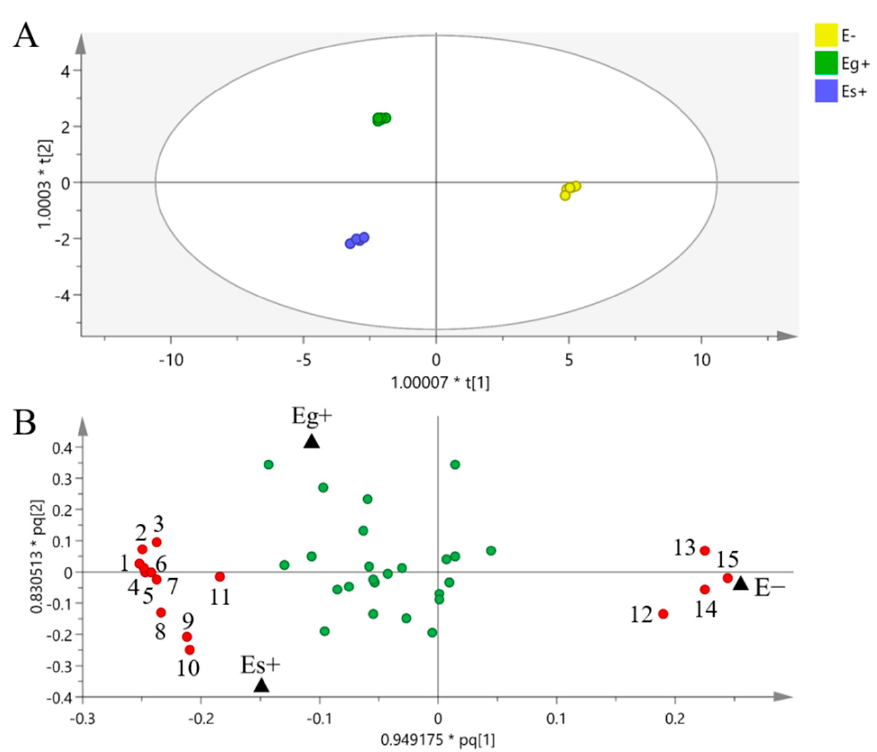
Figure 4. OPLS-DA of the metabolic profiles of Achnatherum sibiricum not infected with endophyte (E − ) and infected with E. gansuensis (Eg+) and E. sibirica (Es+). OPLS-DA: 2 + 3 + 0 latent variables, with R 2 X = 0.648, R 2 Y = 0.998, Q 2 = 0.843. The ellipse in score plot ( A ) defines the 95%